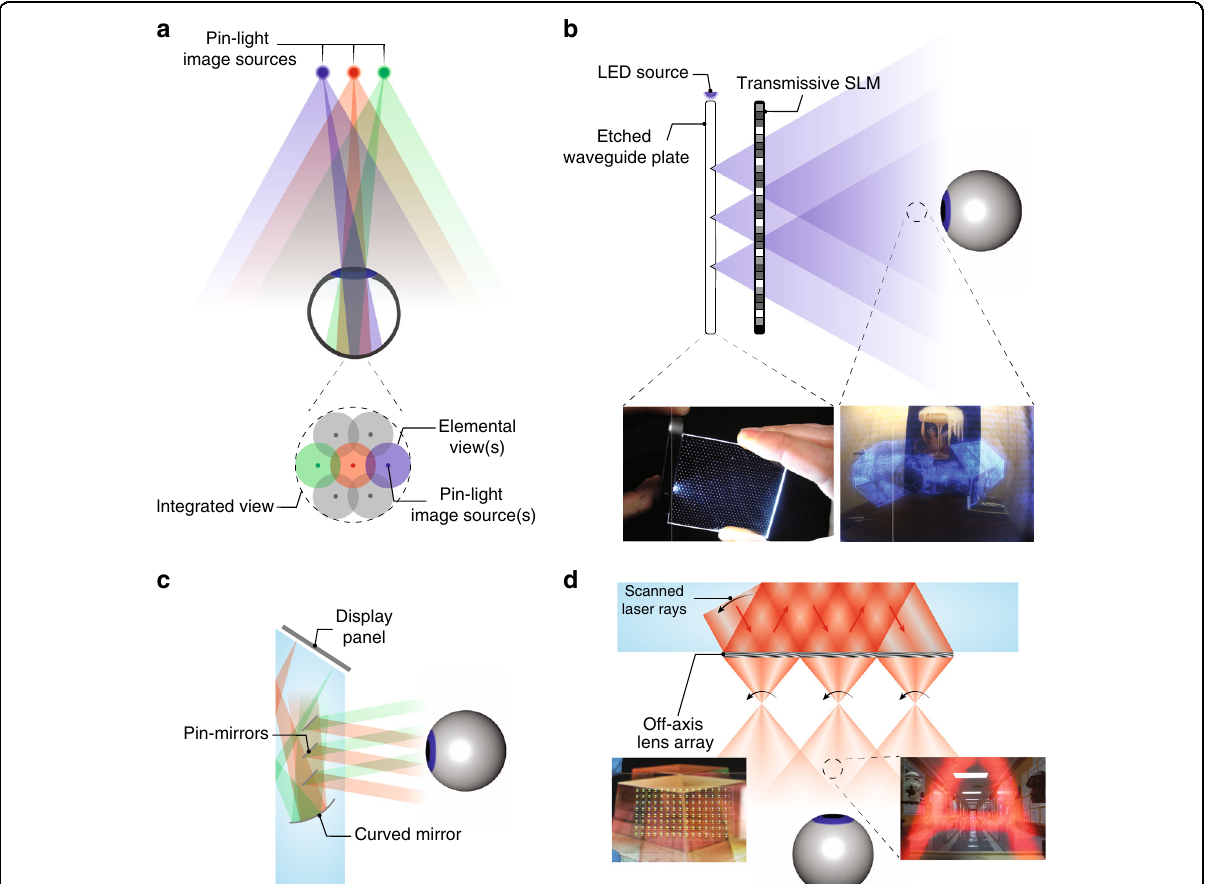
Fig. 11 Illustration of pin-light displays. a Schematic drawing of the working principle of pin-light display. b Pin-light display utilizing a pin-light source and a transmissive SLM. c An example of pin-mirror display with a birdbath optics. d SWD system with LBS image source and off-axis